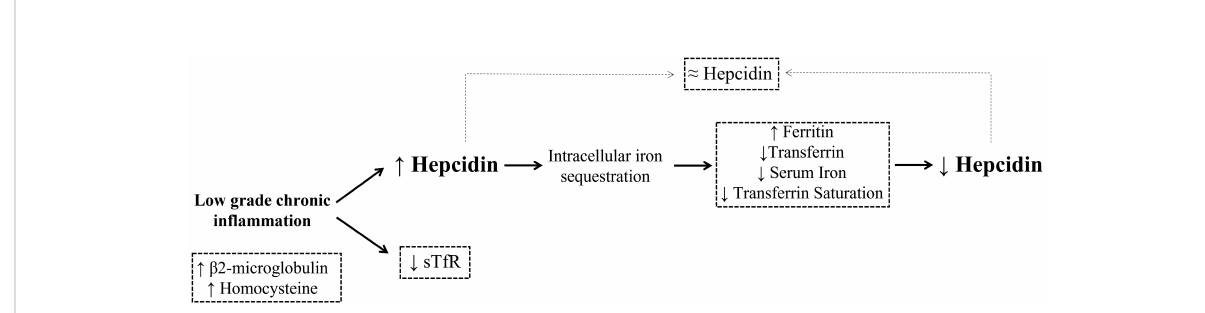
FIGURE 4 Proposed model of functional iron de fi ciency (ID) in virologically suppressed HIV-infected patients. Chronic HIV infection is known to cause a low grade in fl ammation that persists even after a successful ART. This setting is characterized by high levels of proin fl ammatory cytokines that promote hepcidin secretion, causing intracellular iron sequestration mainly in splenic macrophages and hepatic Kupffer cells by increasing stores (ferritin) and decreasing iron traf fi c (circulating iron, transferrin and transferrin saturation). As a result, hepcidin levels would decrease to favor again iron absorption from circulation, compensating then the elevated levels caused by the in fl ammatory environment. On the other hand, the decrease iron tissue demand during infection along with a likely mild bone marrow suppression would diminish the levels of sTfR. Altogether, in fl ammation would drive an impaired mobilization and utilization of the iron stores despite of proper requirements, therefore causing a functional ID in virologically suppressed chronic HIV infected patients. Grid lines represent results in our HIV